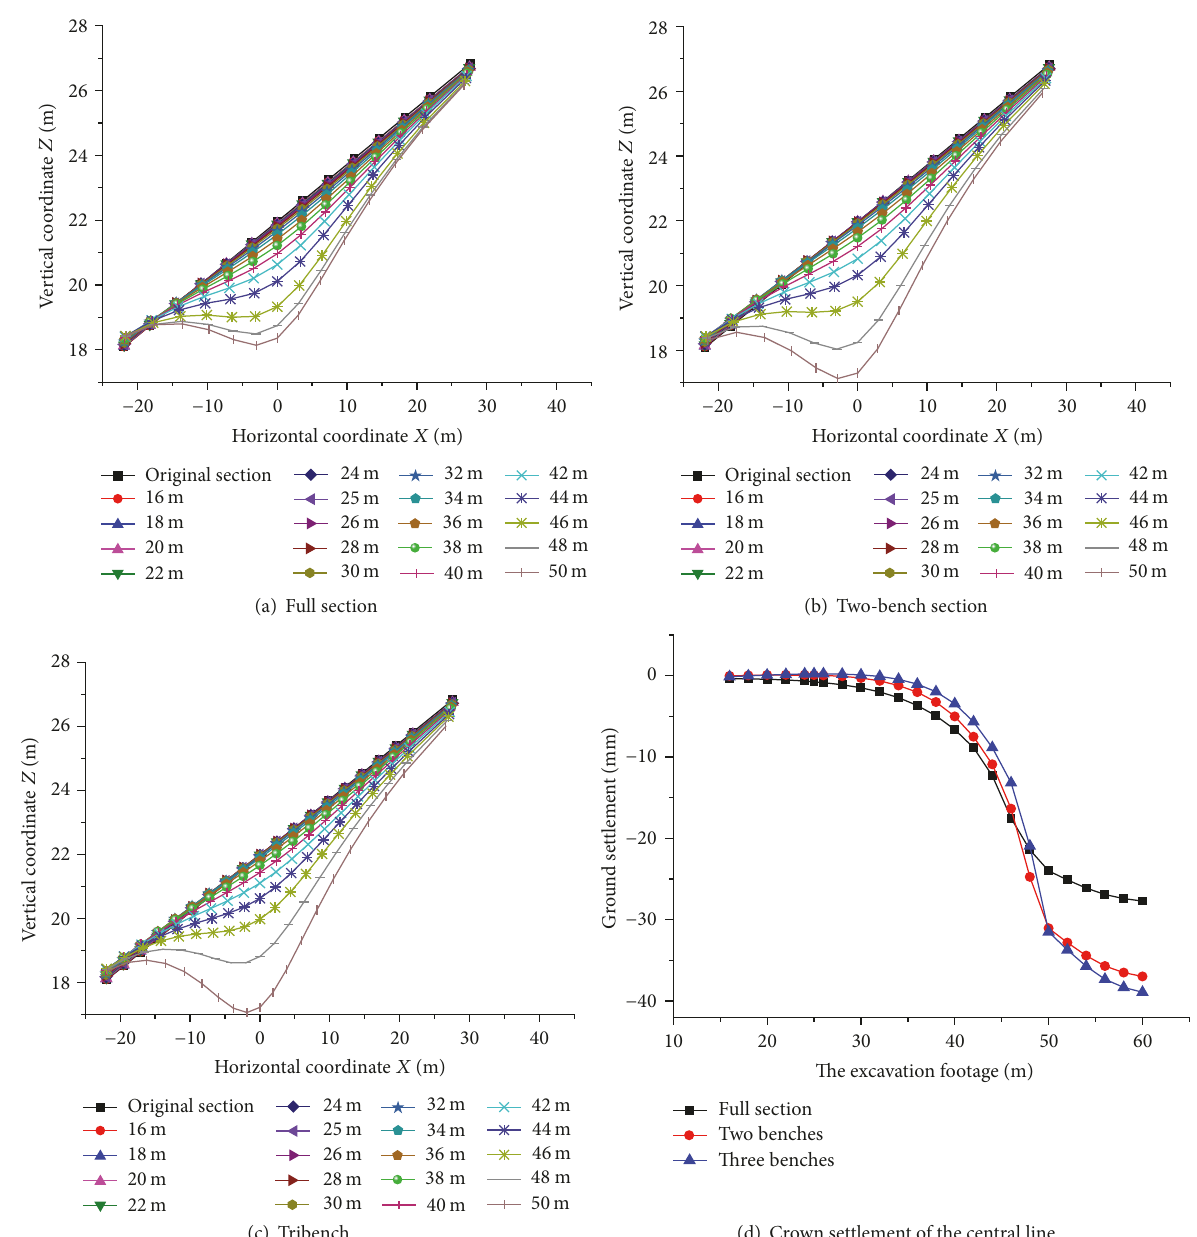
Figure 6: The ground settlement by different